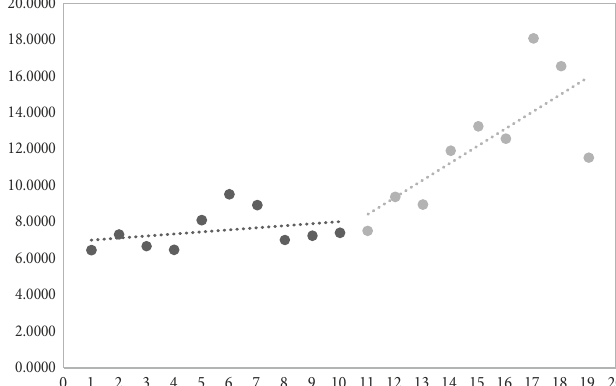
Fig. 6. Profit margin mean analysis: x axis – intangibles level groups in ascending order; y axis – mean value of profit margin; (polynomial regression – Fig. 3A) Source: